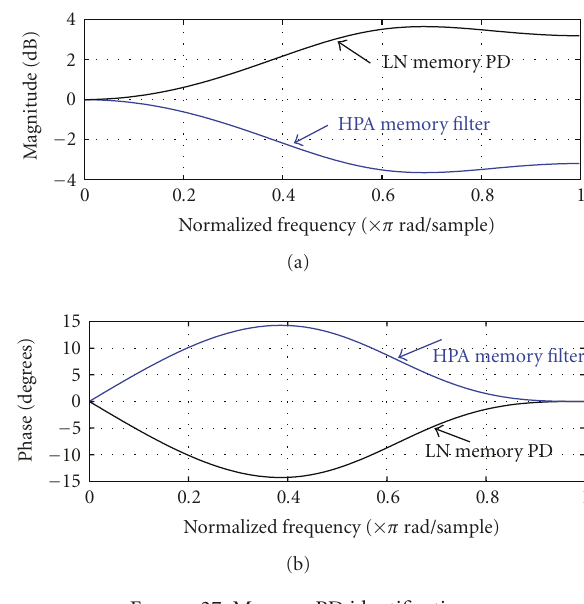
Figure 27: Memory PD